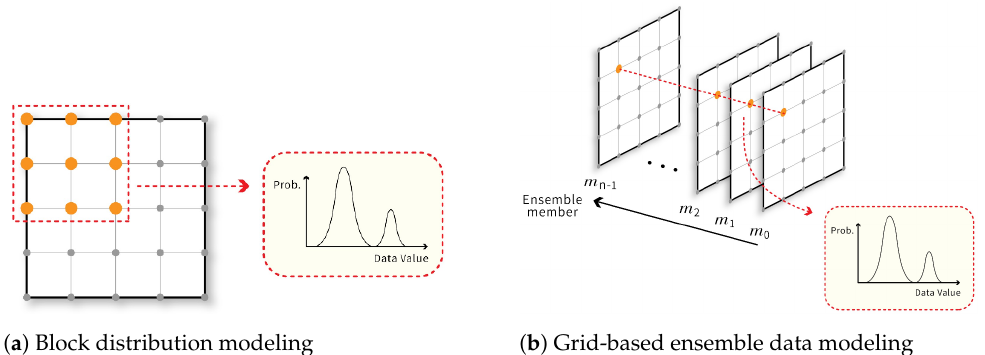
Figure 2. ( a ) illustrates the approach that uses a distribution to model data values in each sub-block to compactly represent a volume or vector dataset. If the data is a vector dataset, the distributions should be multivariant distributions; ( b ) shows the use of a distribution to model data values of all ensemble members at the same grid point to compactly store an ensemble